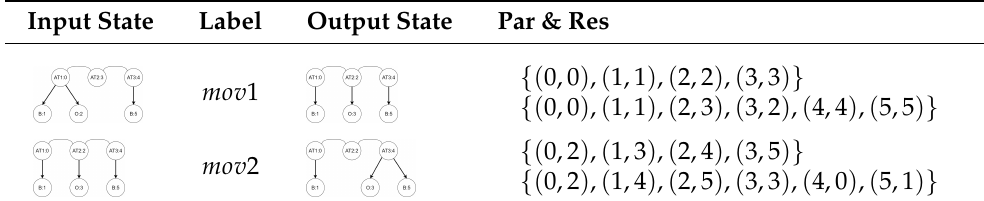
Table 14. Tracking transition system for the first example.